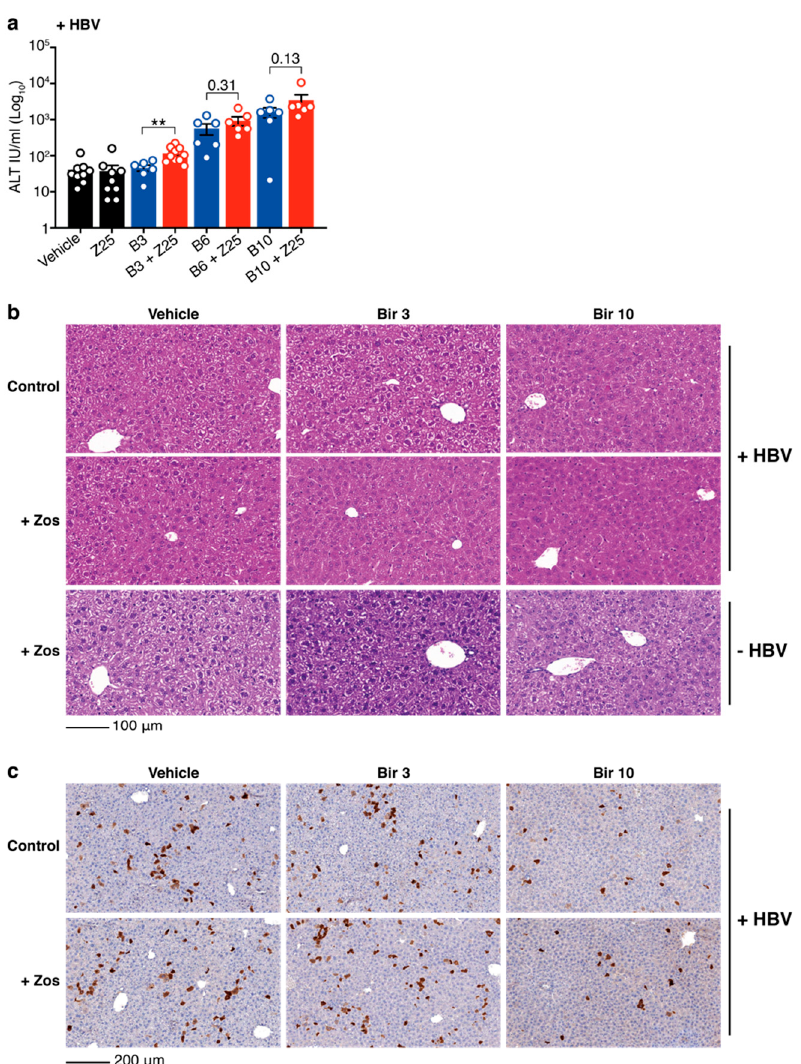
Figure 3. Birinapant plus zosuquidar combination therapy specifically reduces HBV positive cells in the liver of HBV-replicating C57BL / 6 mice. ( a ) ALT levels in the serum of HBV-replicating mice treated as indicated at day 8 (see timeline Figure 2b) with zosuquidar 25 mg / kg ± birinapant 3, 6 or 10 mg / kg. Birinapant (B3) and birinapant + zosuquidar (B3 + Z25) data is reiterated from Figure 2c. ( b ) Hematoxylin and eosin (H&E) staining of livers from HBV-replicating and naïve mice at day 8 and treated as indicated. Scale bar, 100 µ m. ( c ) HBV core antigen (HBcAg) staining of livers from HBV-replicating mice at day 8 and treated as indicated. Scale bar, 200 µ m. Images are representative of n = 4 − 8 mice per group. Graph shows mean ± SEM; ** p < 0.01 (nonparametric Mann-Whitney test).